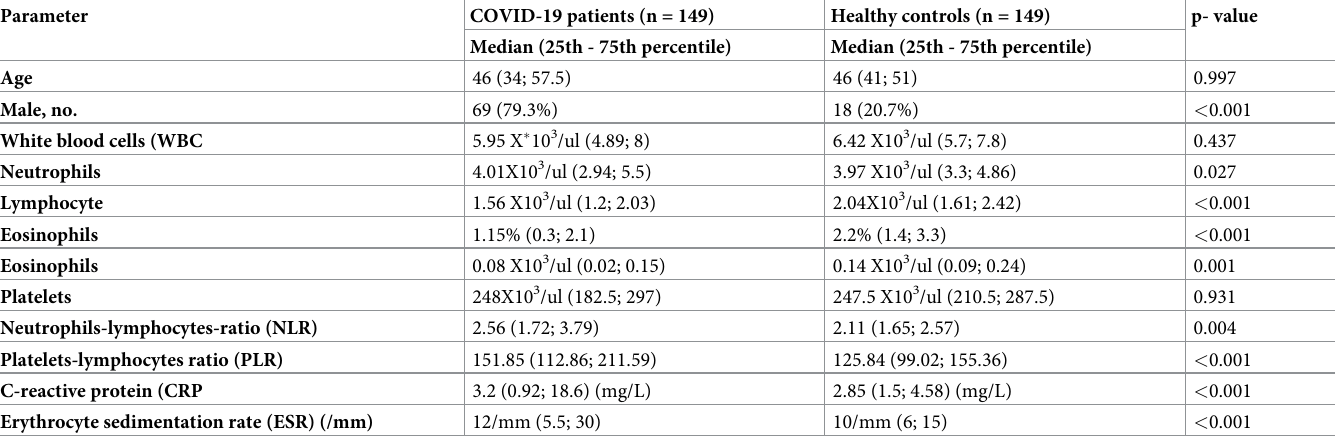
Table 2. Inflammatory markers in COVID 19 patients and healthy